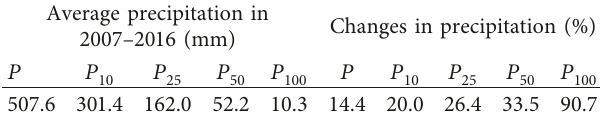
Table 3: Changes in precipitation in the HLR from 2007 to 2016. Average precipitation in 2007–2016 (mm)